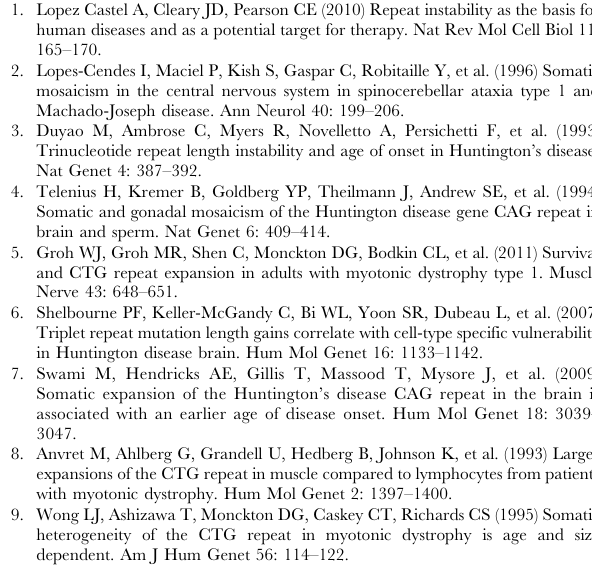
Figure S5 Comparison of HD transgene expression and Hdh expression in the striatum and cerebellum of R6/1 and R6/2 mice of 6 weeks. Primers located upstream of the CAG repeats in exon- 1 were used in both cases. An absolute quantification method was used to compare transgene and Hdh mRNA levels, using genomic DNA from the striatum and cerebellum of R6/1 and R6/2 mice. Levels of PCR products are expressed as equivalent DNA (1 ng eq. DNA corresponds to the PCR signal obtained using 1 ng of